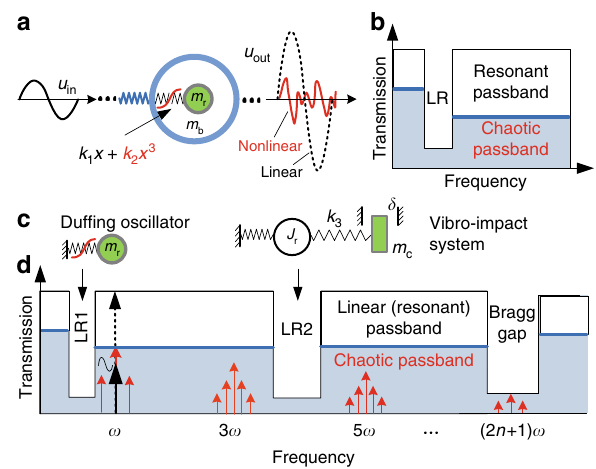
Fig. 1 Schematic and conceptual diagram. a Diatomic NAM model composed of periodic linear base m b coupled with Duf fi ng oscillators m r through the nonlinear spring k 1 x + k 2 x 3 , where k 1 and k 2 are the linear and nonlinear stiffness coef fi cients, respectively. b Its band structure. Here, the passbands become chaotic bands, where a periodic input wave u in generates chaotic output wave ( u out red) with an amplitude is much lower than that of the corresponding linear resonance ( u out dashed black). c Two nonlinear sources in our NAM cell: Duf fi ng oscillator and coupled vibro-impact system ( m c couples to J r through a linear spring k 3 and with a clearance δ ). d Conceptual diagram of the double-ultra mechanism using chaotic bands. LR1 (LR2) represents the fi rst (second) LR bandgap induced by the linearized Duf fi ng and vibro-impact systems, respectively. The black (dashed black) arrow represents the input wave u in (its transmission) in linear resonant passbands and the red arrows represent the frequency components in the chaotic wave u out . In b , d , the light blue (white) areas represent the band structure of the NAM (the corresponding LAM), where the blue lines are the upper limits of the chaotic